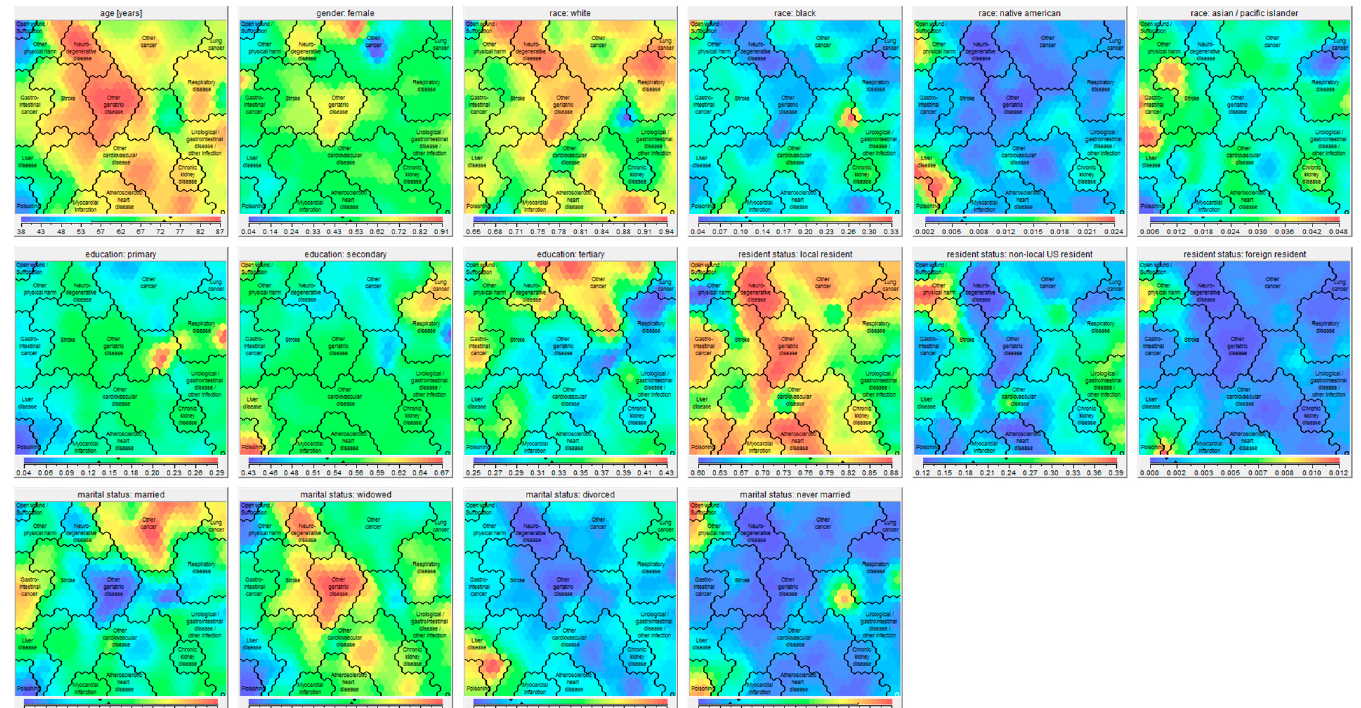
Figure 2. Self-organizing maps showing the socio-demographics (age, gender, race, education, resident status, and marital status) of the 16 clusters. Age: Red parts of the map consist of persons with a high average age at death, whereas blue parts consist of persons with a low average age at death. The exact average ages are given in the bar under the map picture. Gender, race, education, resident status, marital status: red parts of the map consist of high percentages of persons of the indicated gender, race, education, resident status, and marital status, whereas blue parts consist of low percentages of the indicated gender, race, education, resident status, and marital status. The exact percentages are given in the bar under the respective map picture.